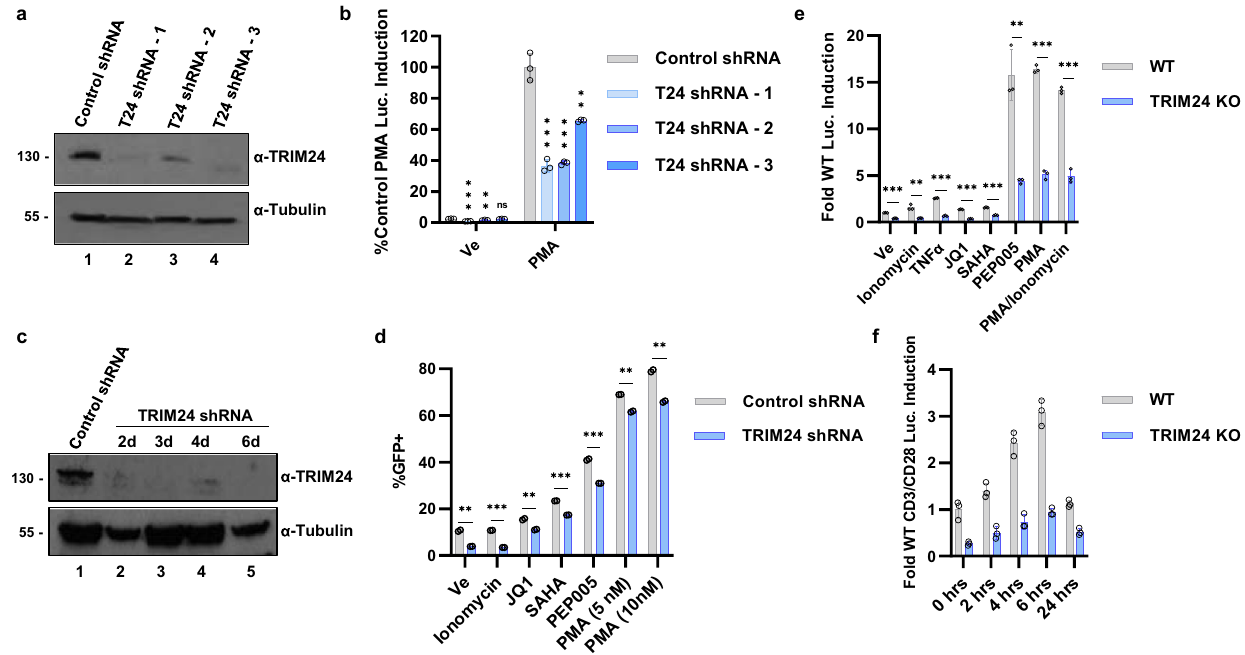
Fig. 4 TRIM24 is an activator of HIV-1 expression in T cells. a Jurkat mHIV-Luciferase cells were transduced with pLKO empty vector control (lane 1) or various TRIM24 targeting shRNA (lanes 2 – 4). Following 3 days of puromycin selection, lysates from transduced cells were analyzed by immunoblotting with antibodies against TRIM24 or Tubulin. b Jurkat mHIV-Luciferase cells transduced with control shRNA vector or TRIM24 targeting shRNA were left untreated (Ve, DMSO) or stimulated with 20 nM PMA for 4 h prior to measuring luciferase activity ( n = 3, mean ± SD). c JLat10.6 cells were transduced with a Control shRNA vector or a TRIM24 targeting shRNA. Following puromycin selection, whole-cell lysates were extracted and subject to immunoblotting against TRIM24 or Tubulin. d Control shRNA or TRIM24 targeting shRNA transduced JLat10.6 cells were cultured for 4 days with puromycin and subsequently incubated with DMSO (Ve), 1 µ M ionomycin, 10 µ M JQ1, 10 µ M SAHA, 10 nM PEP005, and 5 nM or 10 nM PMA, cells were examined 20 h later by fl ow cytometry ( n = 2, mean ± SD). e Wild-type or TRIM24 KO Jurkat mHIV-Luciferase cells were incubated with DMSO (Ve), 1 µ M ionomycin, 10 ng/ µ L TNF α , 10 µ M JQ1, 10 µ M SAHA, 10 nM PEP005, 10 nM PMA or 10 nM PMA/1 µ M ionomycin for 4 h prior to measuring luciferase expression ( n = 3, mean ± SD). f Wild-type or TRIM24 KO Jurkat mHIV-Luciferase were cultured in the presence of CD3/CD28 coated beads with luciferase expression analyzed at the indicated time points ( n = 3, mean ±